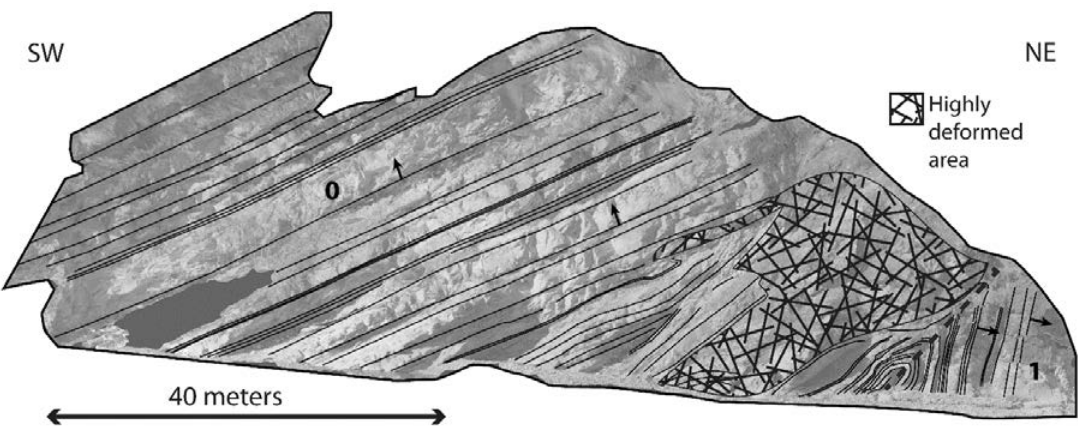
Figure 8. Structural interpretation of DOM 2 (see Figure 4b) projected on a orthorectified image. The view point of the orthorectified image is horizontal and sub-orthogonal to the mean slope direction. Beds (thin black lines) and the main trace of the fold axial plane (grey dashed line) are shown. The numbers mark the 2 main fold limbs recognized by the preliminary visual analysis. Small black arrows show the polarity of the beds.